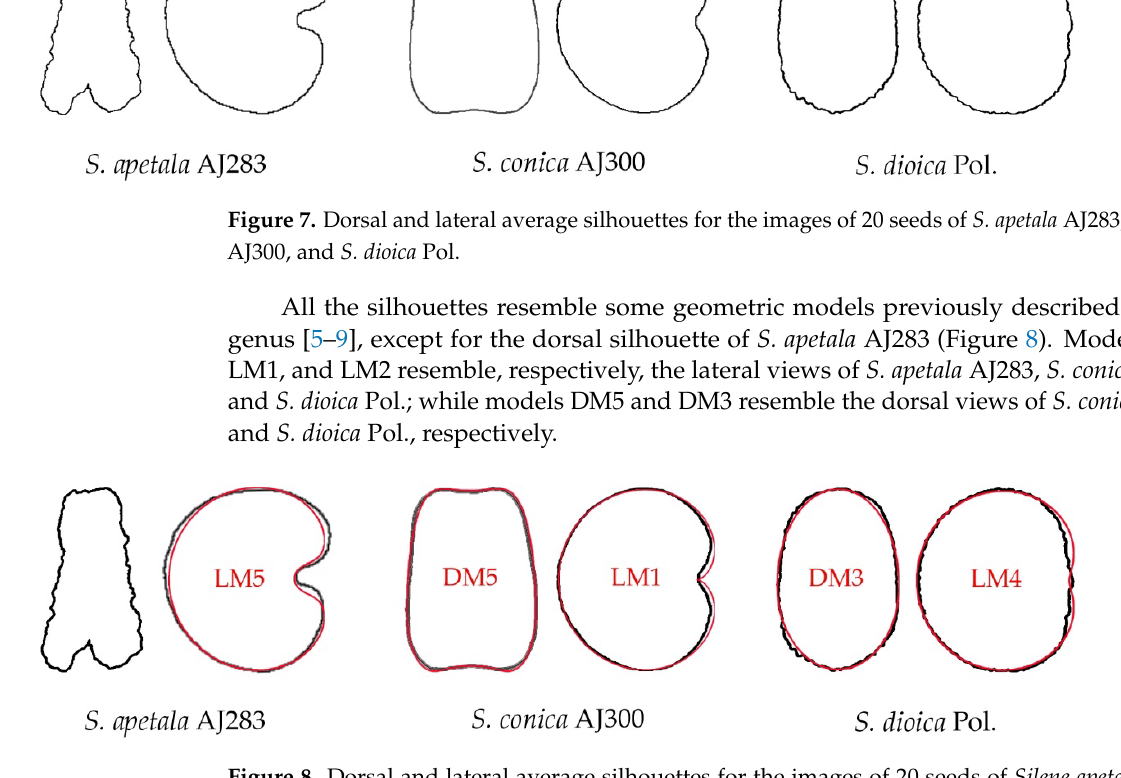
Figure 8. Dorsal and lateral average silhouettes for the images of 20 seeds of Silene apetala AJ283, S. conica AJ300, and S. dioica Pol. with the corresponding models superimposed in red. Models LM5, LM1, and LM4 resemble, respectively, the lateral views of S. apetala AJ283, S. conica AJ300, and S. dioica Pol. DM5 and DM3 resemble the dorsal views of S. conica AJ283 and S. dioica Pol. The dorsal view of S. apetala AJ283 does not adjust to any model described.